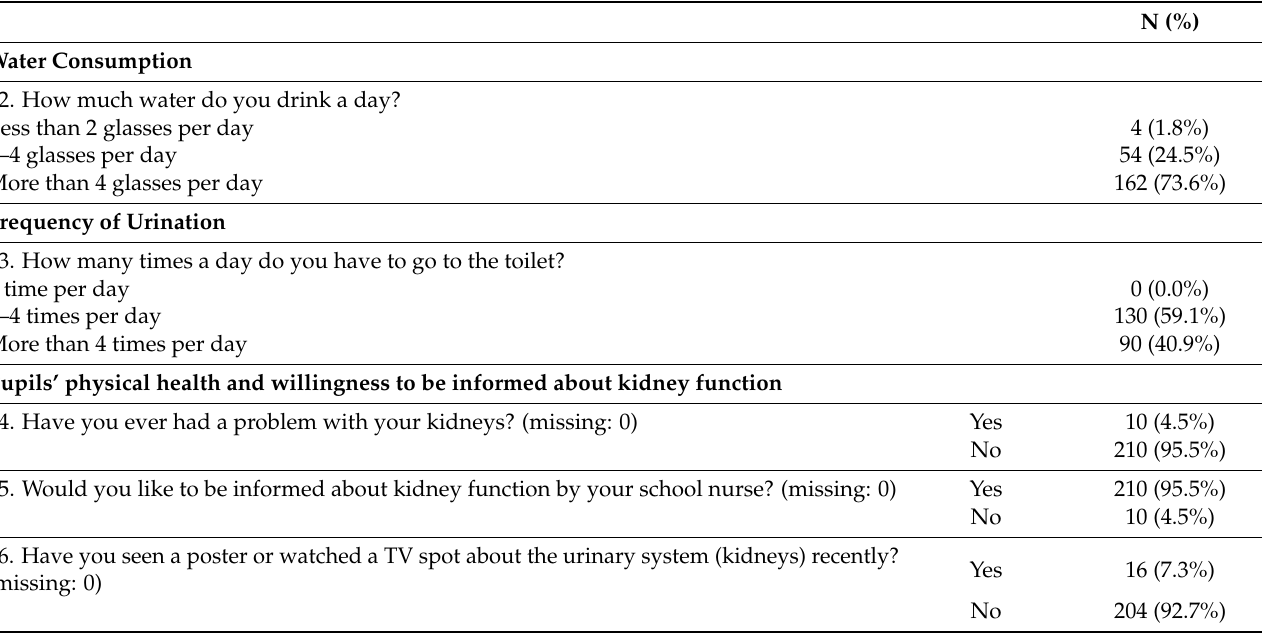
Table 3. Distribution of pupils’ answers regarding water consumption, frequency of urination, physical health and willingness to be informed about kidney